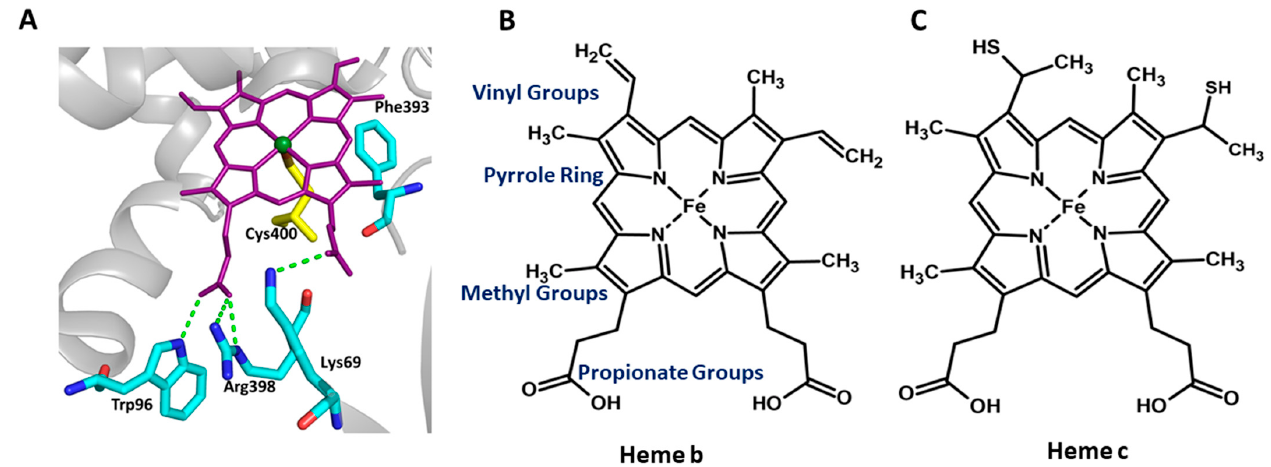
Figure 1. The catalytic pocket of the representative P450 (P450 BM3 ) enzyme and the schematic representation of heme prosthetic groups present in the P450 and non-enzyme proteins. ( A ) Protopor- phyrin IX, the prosthetic group of Cytochrome P450 (purple sticks), interacts with Trp96, Arg398, and Lys69 (Cyan sticks). Cys400 (yellow sticks) is a highly conserved residue that forms the heme–thiolate bond. Phe393 is present within the heme-binding motif of P450 BM3 , and positioned close to the Cys400, and is represented by cyan sticks. ( B , C ) Comparison of different heme groups. Heme b is the prosthetic group in cytochrome P450 and myoglobin, whereas heme c is the prosthetic group in Cytochrome C.